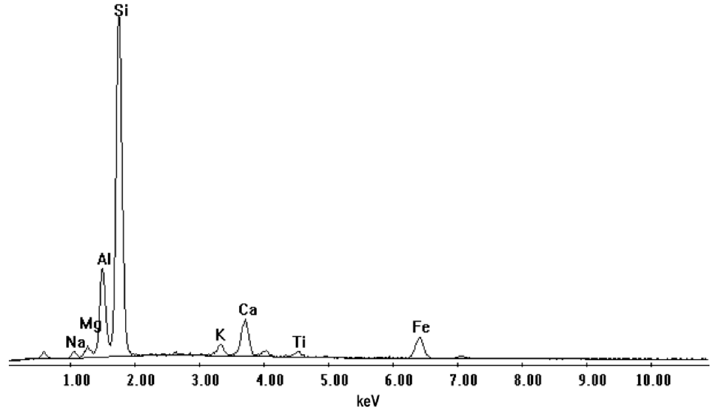
Figure 3. EDS analysis of volcanic powder.